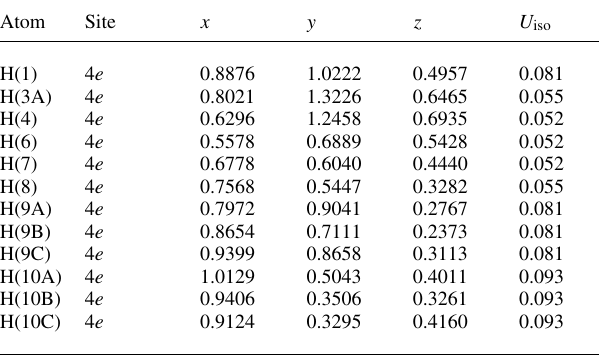
Table 2. Atomic coordinates and displacement parameters (in Å 2 )